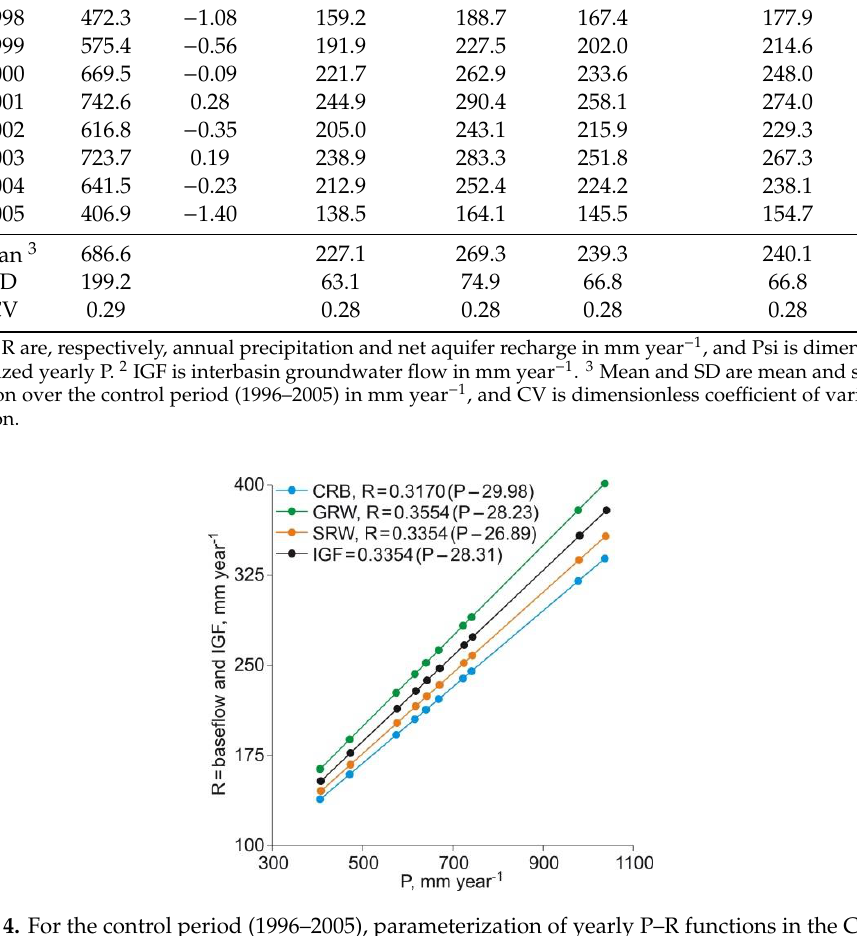
Figure 4. For the control period (1996–2005), parameterization of yearly P–R functions in the CRB and upstream GRW and SRW contributing areas; yearly R equals yearly baseflow. Yearly IGF series refers to the surface-weighed sum of upstream R = baseflow from GRW and SRW areas contributing to the CRB streamflow. In all cases, the Pearson coefficient of correlation is 1.